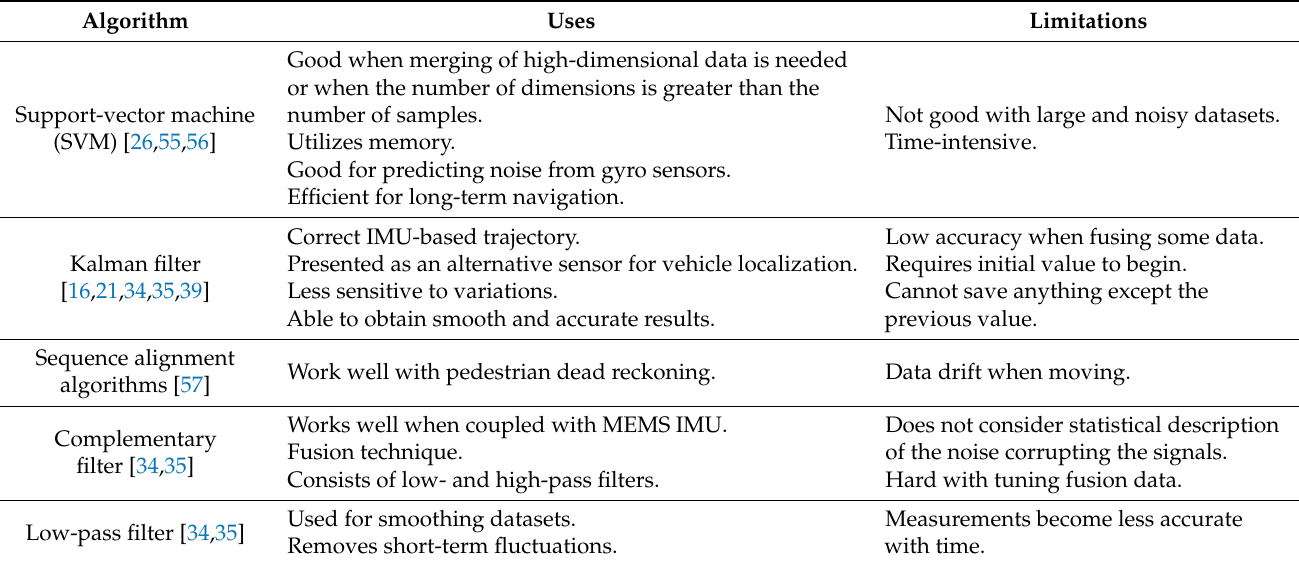
Table 2. Most relevant algorithms available in the